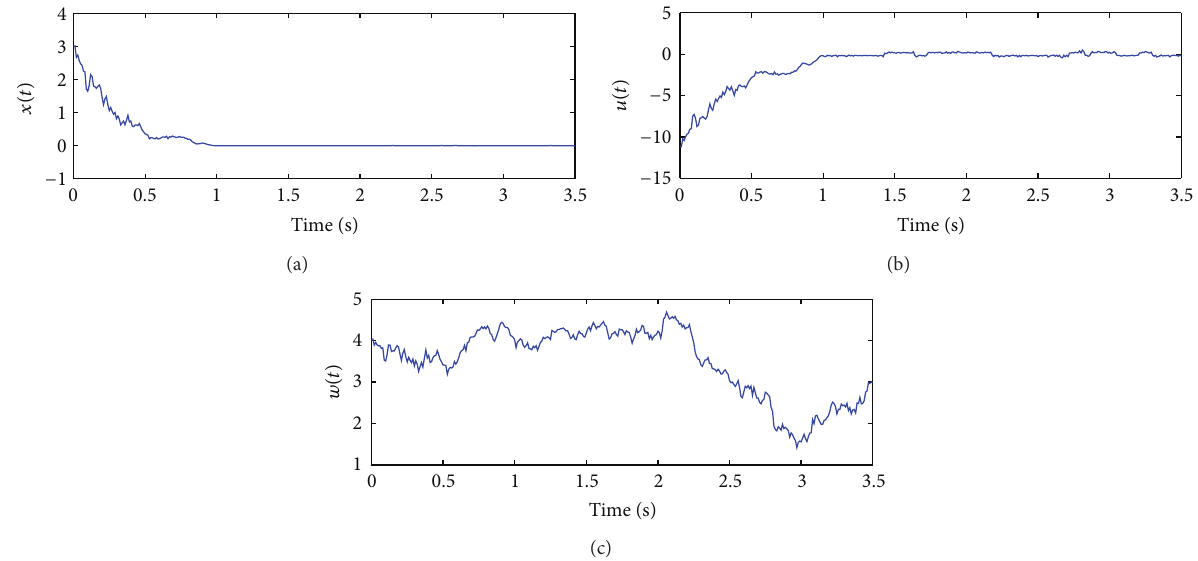
Figure 3: The response of the state 𝑥(𝑡) , the control 𝑢(𝑡) , and the Wiener process 𝑤(𝑡) in Example 1 for initial conditions as 𝑥(0) = 3.